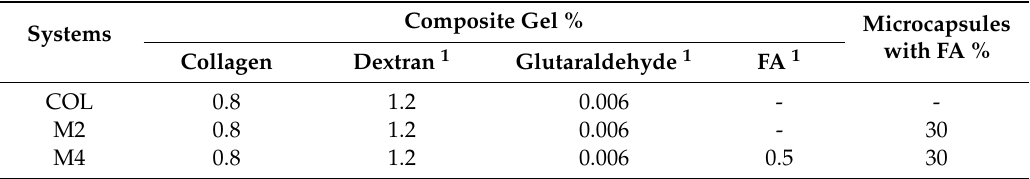
Table 1. The Composition of the Studied